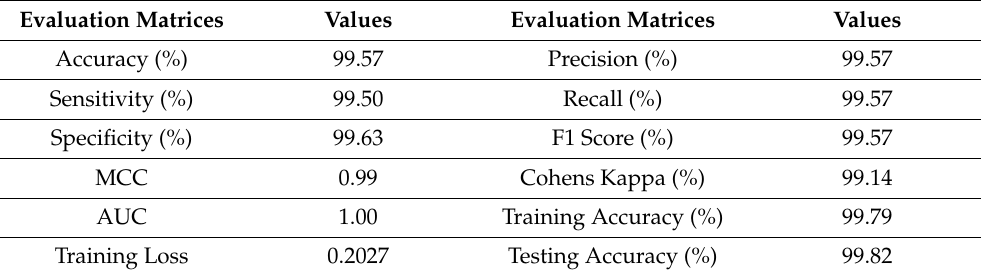
Table 2. Results of Proposed Ensemble Learning Model with Independent set Test.